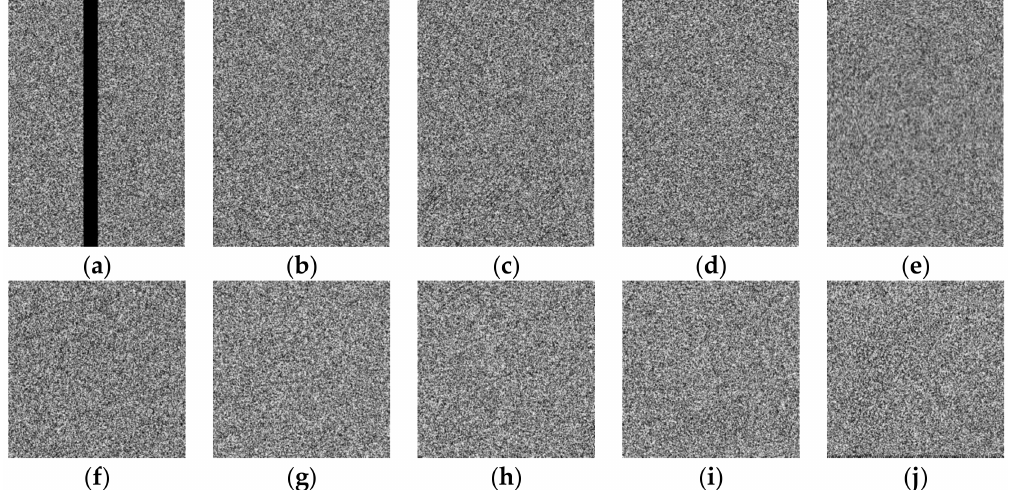
Figure 8. Another example of collecting 5 shared images with one attacked shared image in a (5, 4, {2, 3, 4, 5}) XOR-based progressively secret image sharing, ( a ) the attacked shared image, ( b – e ) the correct shared images, ( f – j ) the recover results by using ( a – e